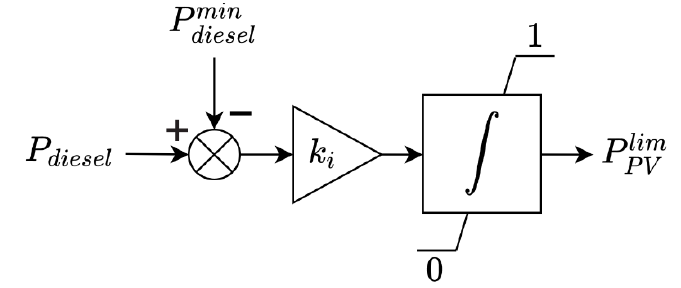
Figure 4. Integral controller scheme without the BESS.